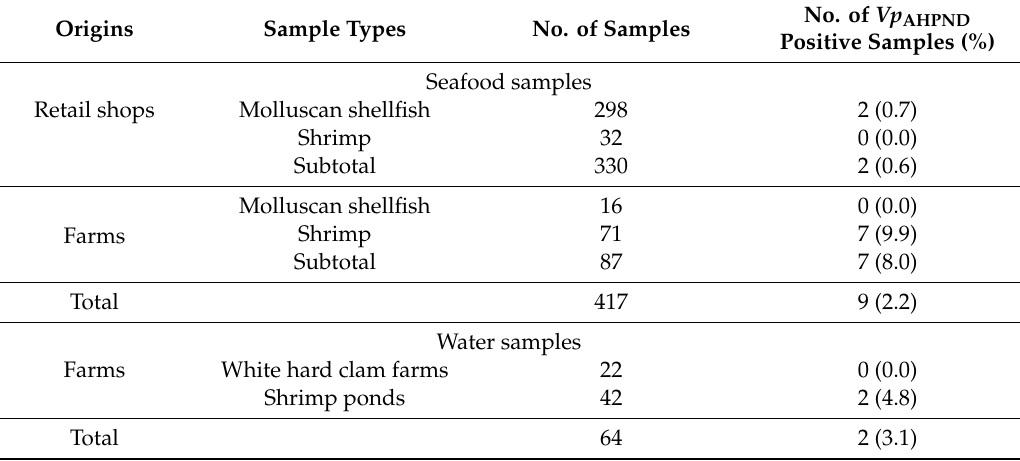
Table 1. Prevalence of Vp AHPND in shrimp, molluscan shellfish, and water samples in the Mekong Delta,